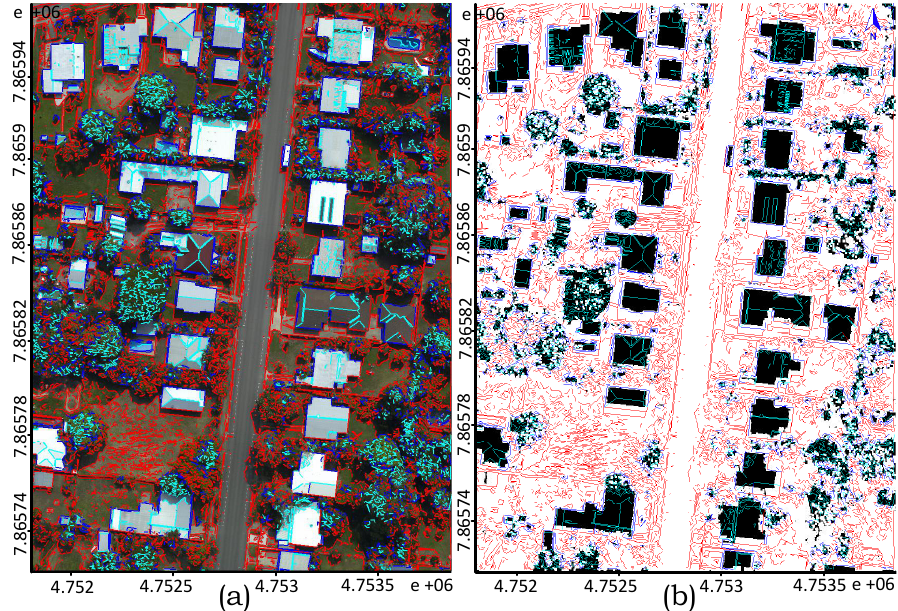
Figure 5. Image line extraction: ( a ) All classified lines on RGB Orthoimage; ( b ) All classified lines on the building